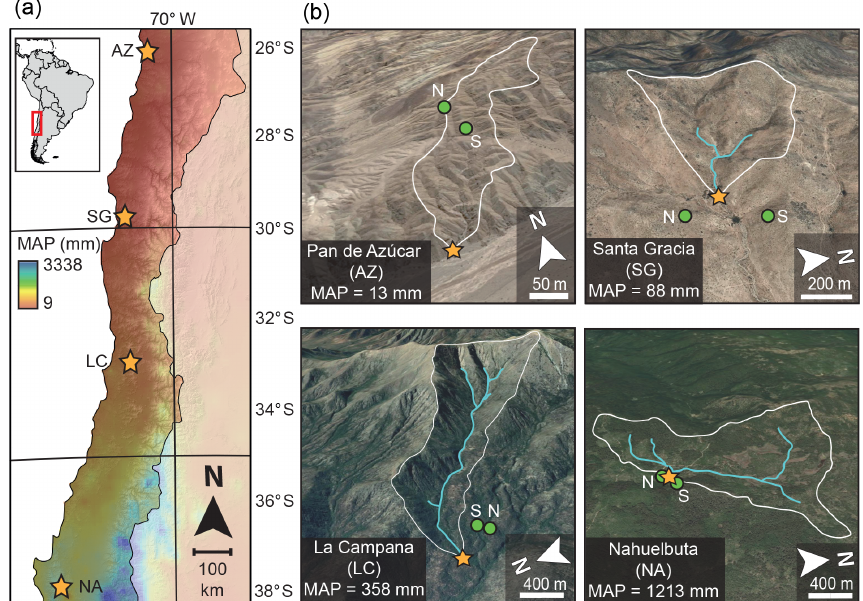
Figure 3. Research areas located on a precipitation gradient in the Chilean Coastal Cordillera. (a) The catchment locations (stars) on a mean annual precipitation (MAP) map from Climate Hazards Group InfraRed Precipitation (CHIRPS), underlain by a Shuttle Radar Topography Mission (SRTM) DEM-derived hillshade map. (b) Google Earth images showing the sample locations (stars), catchment outlines (white), channels with an upstream area of 0.2km 2 (blue lines), and the locations of two 10 Be depth profiles measured by Schaller et al. (2018) in soil pits on a north-facing (N) and south-facing (S) slope (green